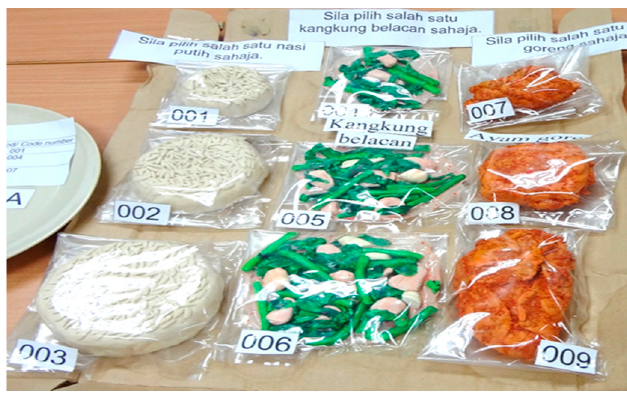
Figure 1. Food models for carbohydrates, vegetables, and protein, with different portion sizes. Table 1. Participants’ socio-demographic and anthropometric data at baseline.